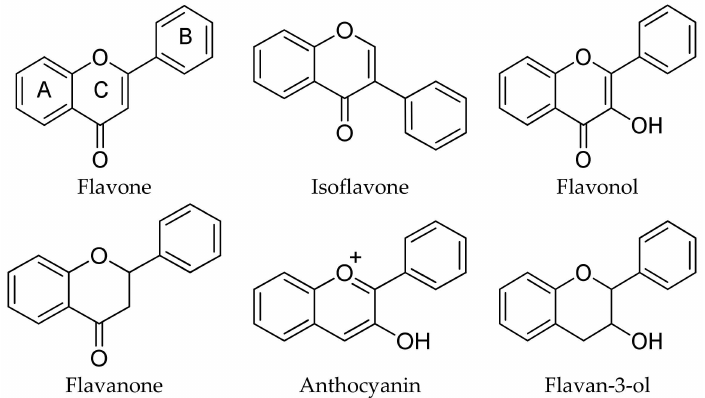
Figure 7. Basic structure and classification of the most important flavonoids.